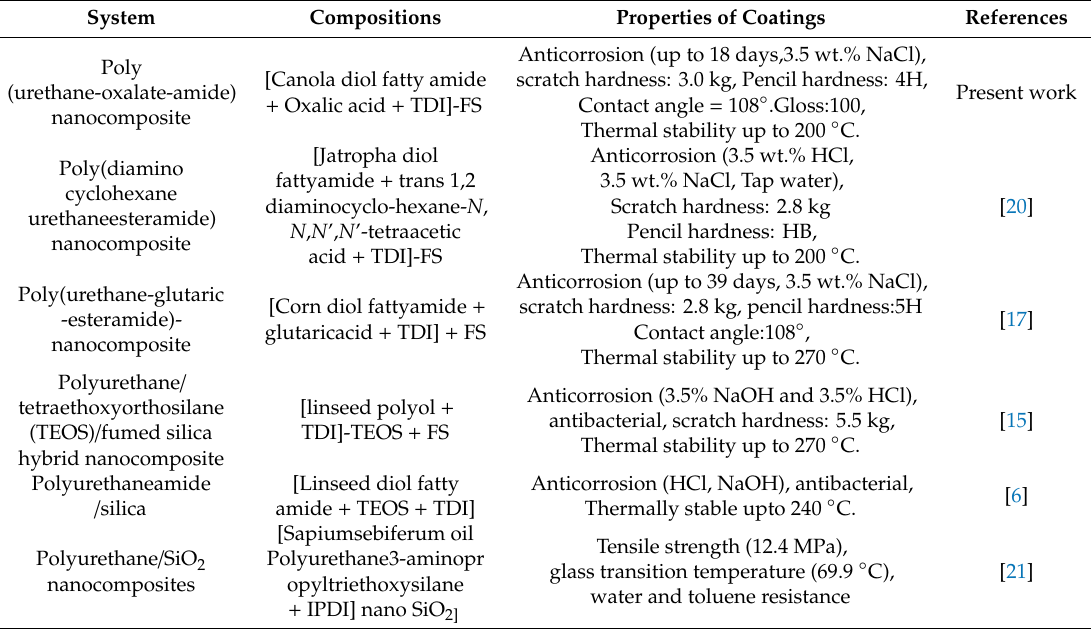
Table 1. Comparative studies of seed oil based polyurethane / fumes silica (FS) composites.